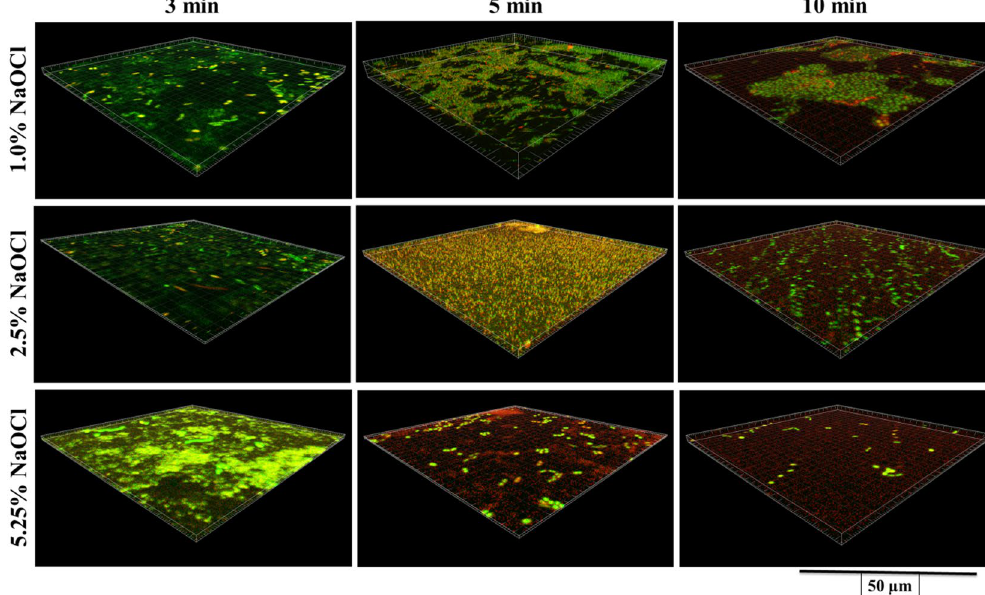
Figure 6. CLSM image of 48 h biofilms after treatment with different concentrations of NaOCl for 3 min, 5 min and 10 min.